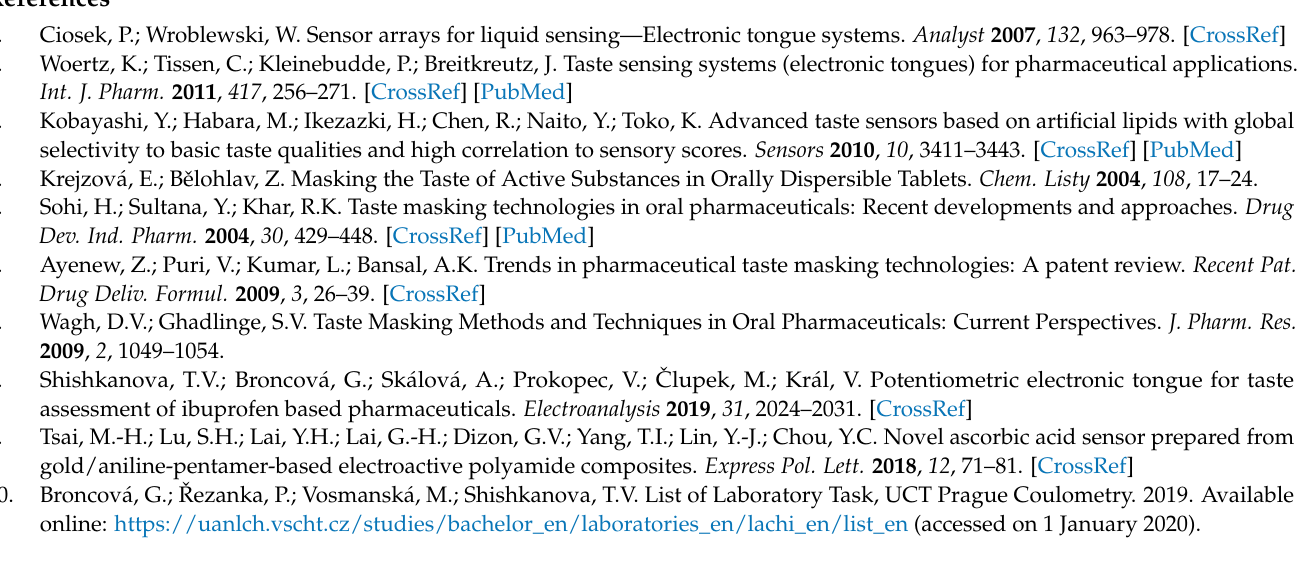
Figure S2: Dependence of the indication current on the time in the blank experiment (Bl) and in the analysis of samples of effervescent tablets A–E (marked S_A–S_E), Table S1: Composition of effervescent tablets (labeled S_A–S_E), Table S2: Measured and calculated data of coulometric titration of ascorbic acid (AA) in effervescent tablet samples (labeled S_A–S_E) for n = 6. The volume of 1 mL was pipetted to the